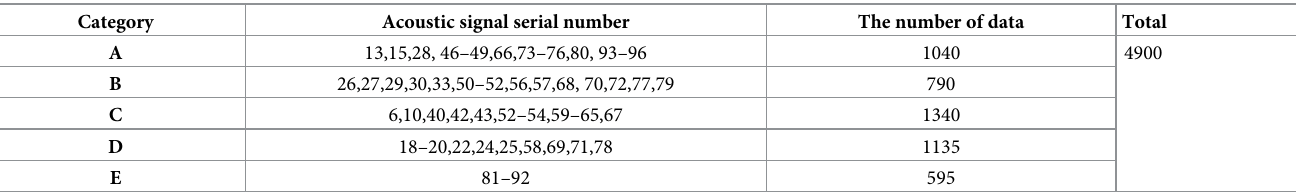
Table 2. Actual size of the dataset